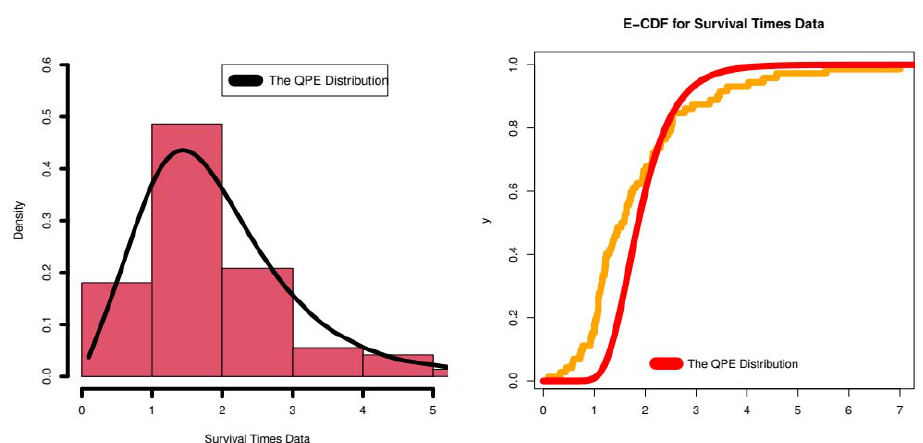
Figure 6. E ‐ PDF ( left panel ) and E ‐ CDF ( right panel ) for survival times data.